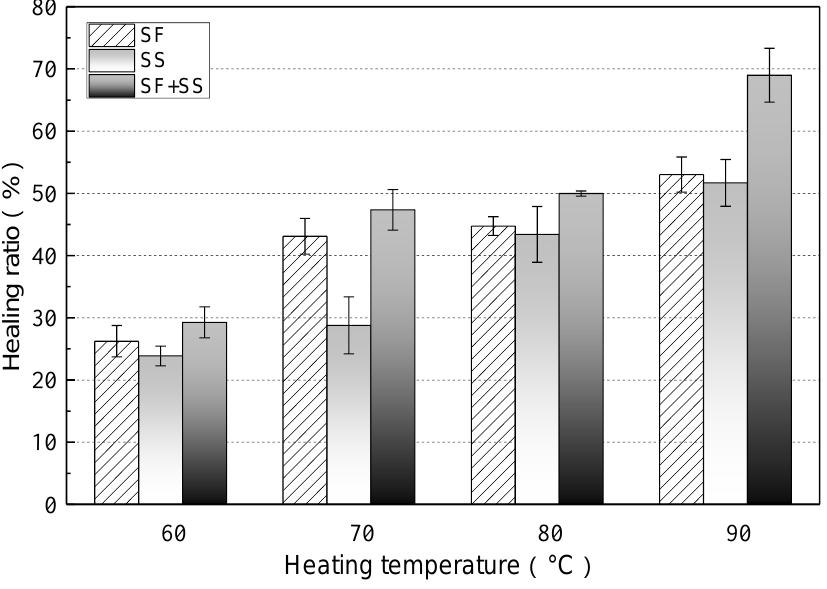
Figure 8. Healing ratio of asphalt mixture under different heating temperatures